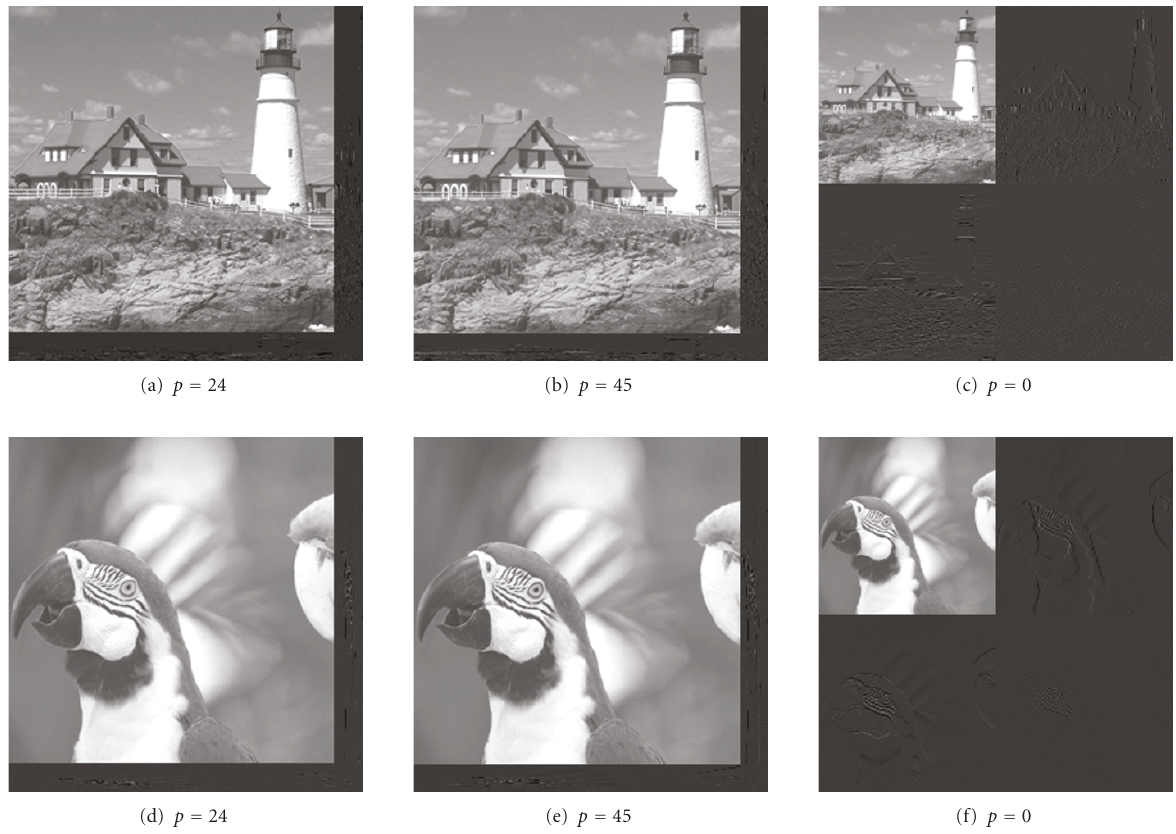
Figure 3: First-level decomposition of the Lighthouse and Parrot images: (a)-(d) p = 24, (b)-(e) p = 45, and (c)-(f) p =